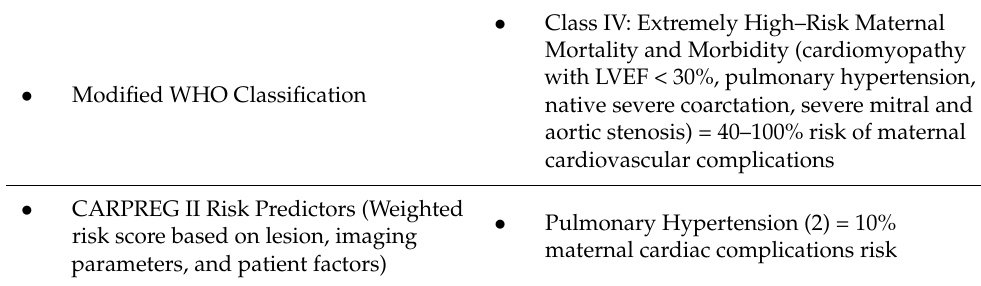
Figure 1. Classification of pulmonary hypertension. mPAP = mean pulmonary artery pressure. PVR = pulmonary vascular resistance. PAWP = pulmonary arterial wedge pressure. WU = Wood units. Table 1. Maternal cardiovascular risk assessments for patients with pulmonary